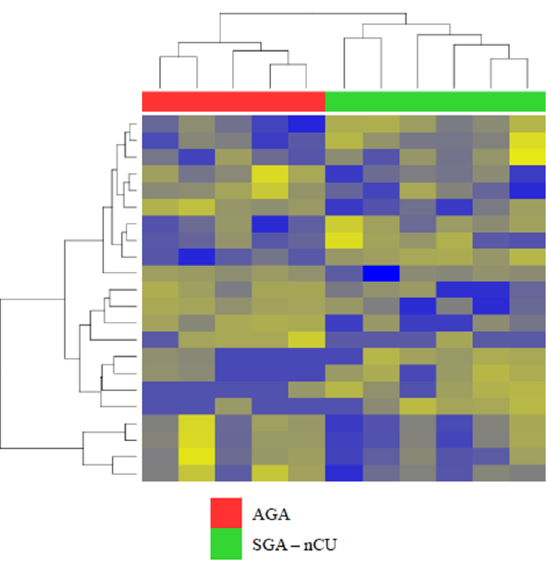
Figure 2. Heat map of the Z-scores of exosomal miRNAs for the SGA-nCU (n = 6) and AGA (n = 5) groups. Table 4. Fold change in exosomal miRNA expression in the SGA-nCU compared with the AGA group.